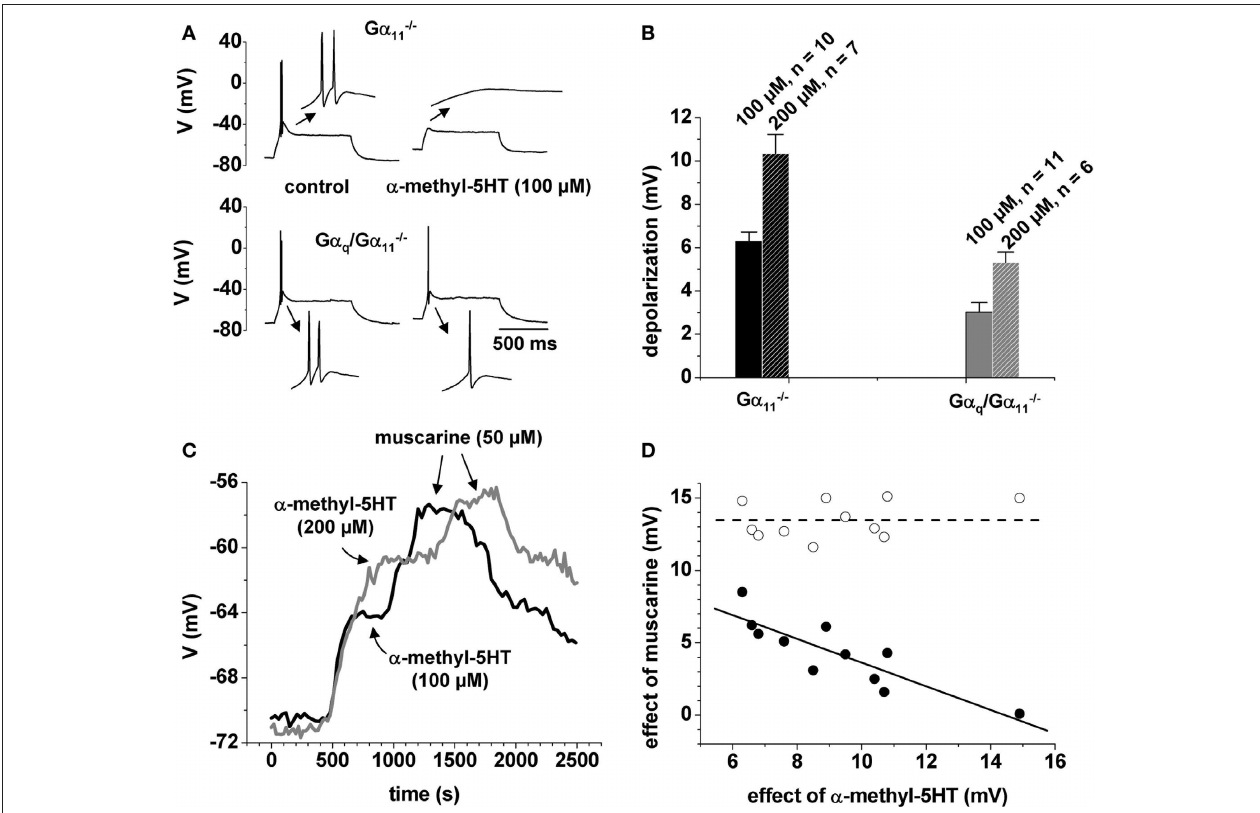
FiGure 1 | Membrane potential and muscarinic signaling are influenced by α -m-5-HT. (A) Firing pattern in a control mouse (upper panel) and in G α G α − / − (lower panel) under control conditions (left traces) and in the presence 11 of α -m-5-HT (right traces). The insets show the low-threshold Ca 2 + potentials at a ten times expanded timescale. (B) Mean bar graph representation of the depolarization induced by two different substance concentrations as indicated. (C) Voltage vs. time plot of two individual cells from control animals (black line: application of 100 μM α -m-5-HT followed by application of 50 μM